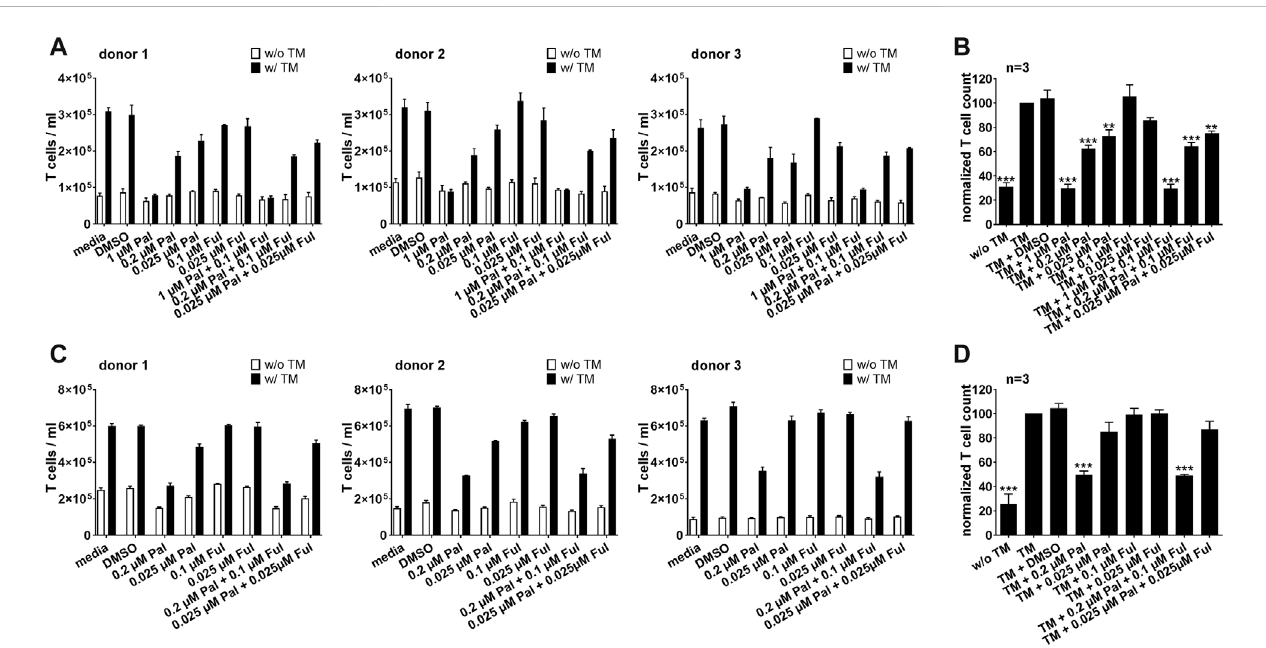
FIGURE 4 Effect of palbociclib and fulvestrant on TM-mediated UniCAR T cell expansion. eFluor ™ 670 + UniCAR T cells and (A,B) PC3-PSCA/PSMA Luc+ or (C,D) LNCaP-PSCALuc+cellswereincubatedwithorwithout30 nMofPSCATM.Palbocicliband/orfulvestrantwereaddedatindicatedconcentrations.After96 h, numbers of eFluor ™ 670+ UniCAR T cells were determined by fl ow cytometry using the MACSQuant ® Analyzer. (A,C) Each diagram shows average T cell counts ± SEM of triplicates for one T cell donor. (B,D) Graphs summarize relative UniCAR T cell counts ± SEM of three different T cell donors. UniCAR T cell numbers in the presence of tumor cells and TM ( “ TM ” ) were equalized to 100%. (*** p ≤ 0.001 compared to control sample “ TM ” ; One-way ANOVA with posthoc Dunnett multiple comparison